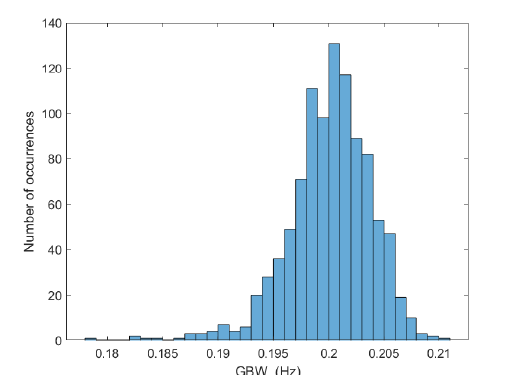
Figure 19. Monte Carlo simulation of our proposed CMOS fractional-order integrator shown in Figure